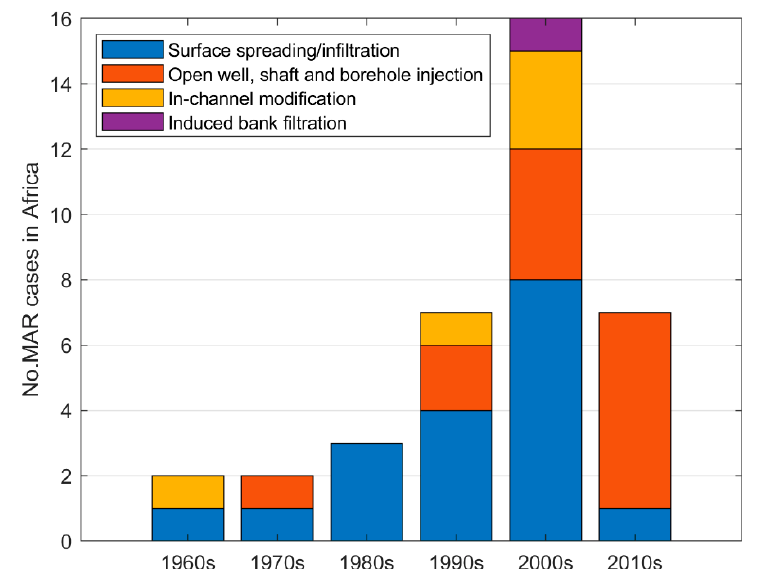
Figure 3. Historical development of MAR cases in Africa where starting date is known. For each decade, the number of new projects is given (n = 37).